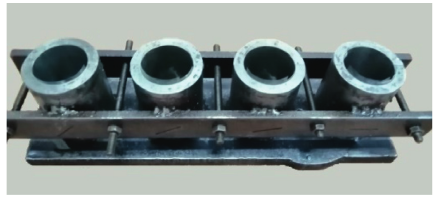
Figure 6: Preparation of